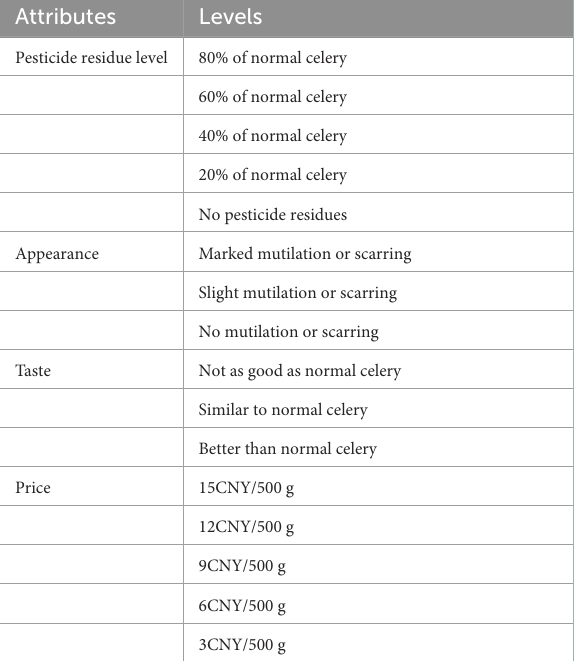
TABLE 1 Attributes and levels used in the discrete choice experiment (DCE). Attributes